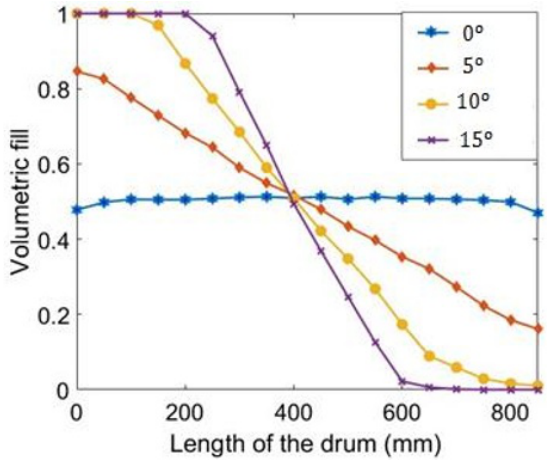
Fig. 2 . Volumetric fill along the length of the drum for  = 0 o , 5 o , 10 o and 15 o .